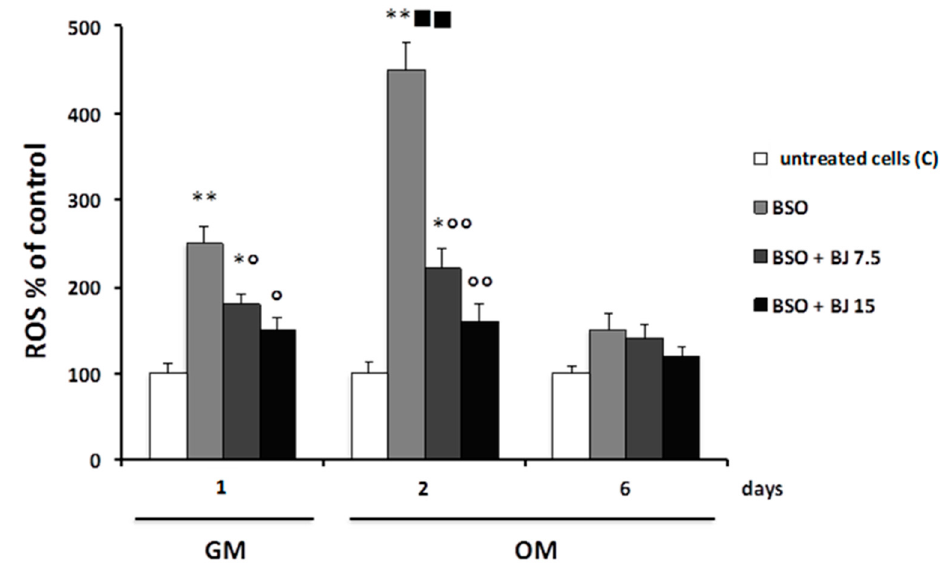
Figure 1. BJ effect on intracellular reactive oxygen species (ROS) production in BSO-treated SaOS-2 cells. Intracellular ROS, detected by measuring the fluorescence intensity of the probe 2 ′ ,7 ′ -dichlorodihydrofluorescein diacetate (H 2 DCFDA), were measured in SaOS-2 cells treated or untreated (C; control) with BSO or BSO + BJ containing 7.5 or 15 μ g ∙ mL − 1 total soluble polyphenols (TSP) for one day in growth medium (GM) and subsequently treated or untreated (C; control) for two or six days in osteogenic medium (OM), as reported in Section 2. ROS data, normalized on total protein content, are expressed as a percentage of the C values, and they are the means ± SEM of four experiments repeated in triplicate; * p ≤ 0.05, ** p ≤ 0.001 compared to C cells; ○ p ≤ 0.05, ○○ p ≤ 0.001 compared to BSO-treated cells; ■■ p ≤ 0.001 compared to BSO-treated cells for one day in GM.